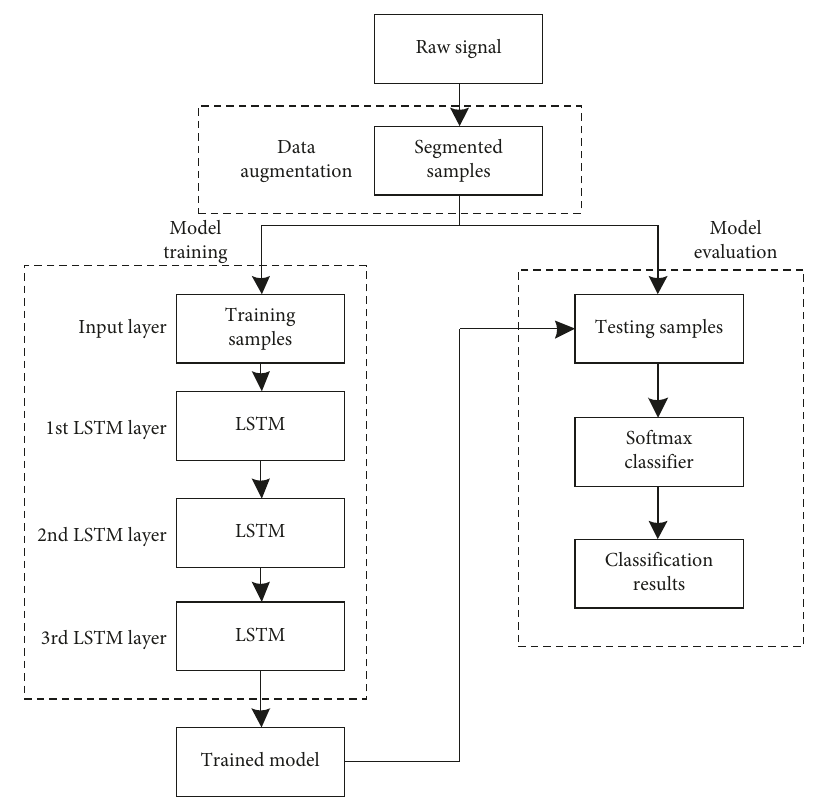
Figure 3: The flow chart of the proposed method.